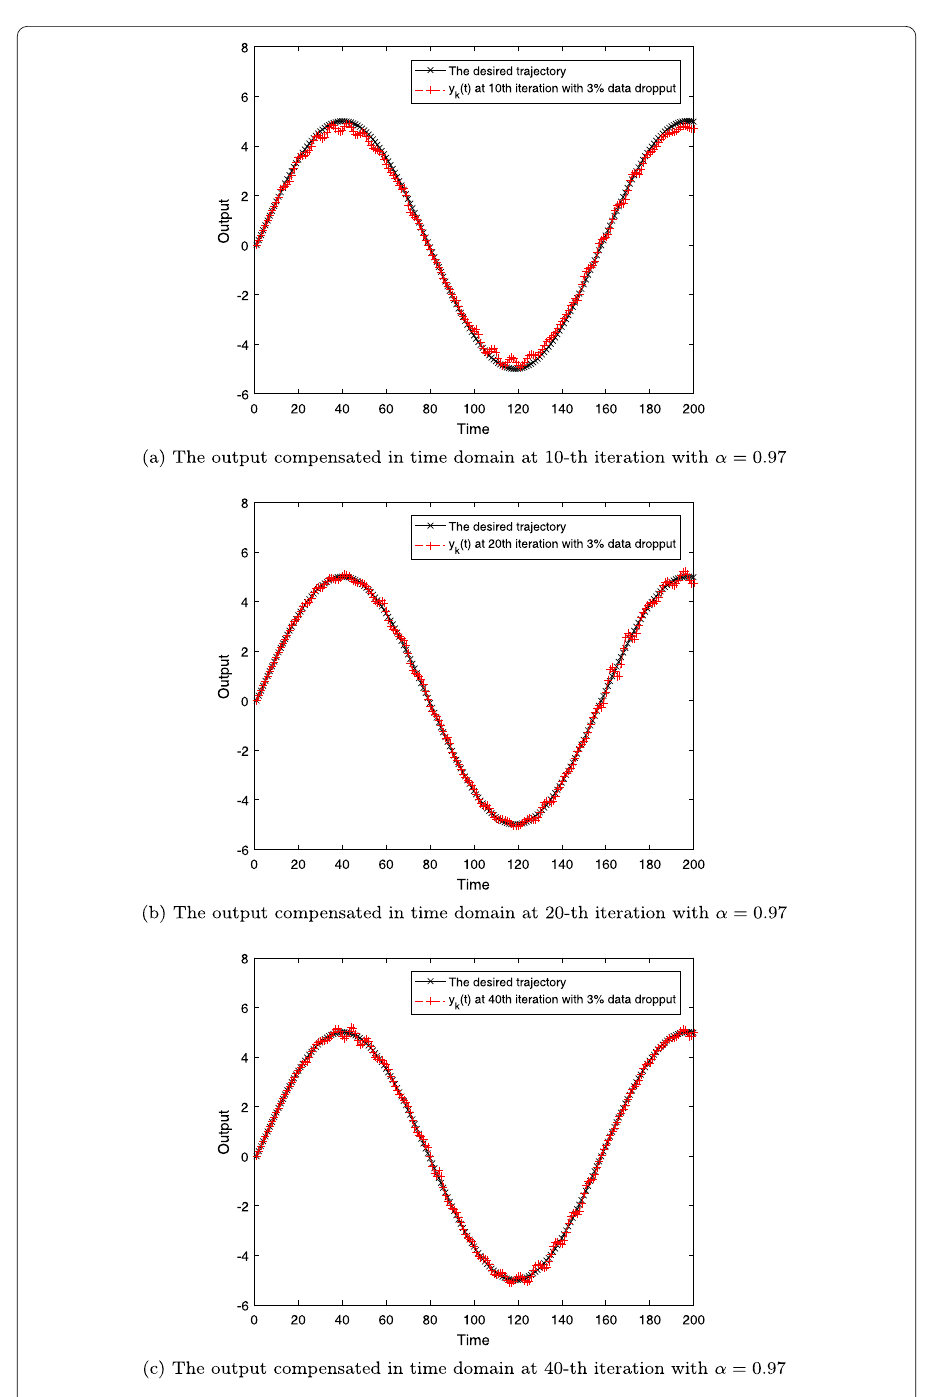
Figure 6 The output compensated in time domain at different iterations with α = 0.97